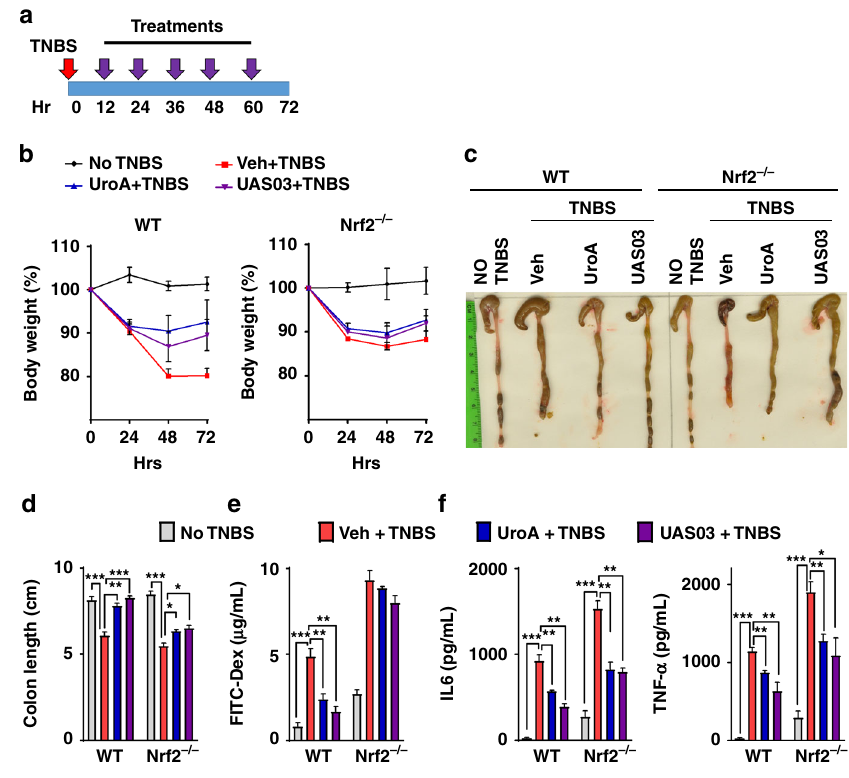
Fig. 7 UroA/UAS03 utilize Nrf2 pathways to mitigate colitis. a – e Colitis was induced using TNBS in C57BL/6 (WT) and Nrf2 − / − mice ( n = 4 – 5/group 7 – 8 week old age). Mice were treated with Veh or UroA/UAS03 (20 mg/kg bodyweight) every 12 h post TNBS administration ending at 72 h. Representative data from two independent experiments is shown. a TNBS-induced colitis experimental design and treatment regimen. b Percent body weight loss (No TNBS- Solid black line; Veh + TNBS- Solid red line; UroA + TNBS- Solid blue line; UAS03 + TNBS- Solid purple line), c representative colon images, d colon lengths, e gut permeability, f serum levels of IL-6 and TNF- α were determined. Statistical analysis was performed (unpaired t -test) using Graphpad Prism software. Error bars, ±SEM *** p < 0.001; ** p < 0.01 * p < 0.05. Source Data are provided as a Source Data